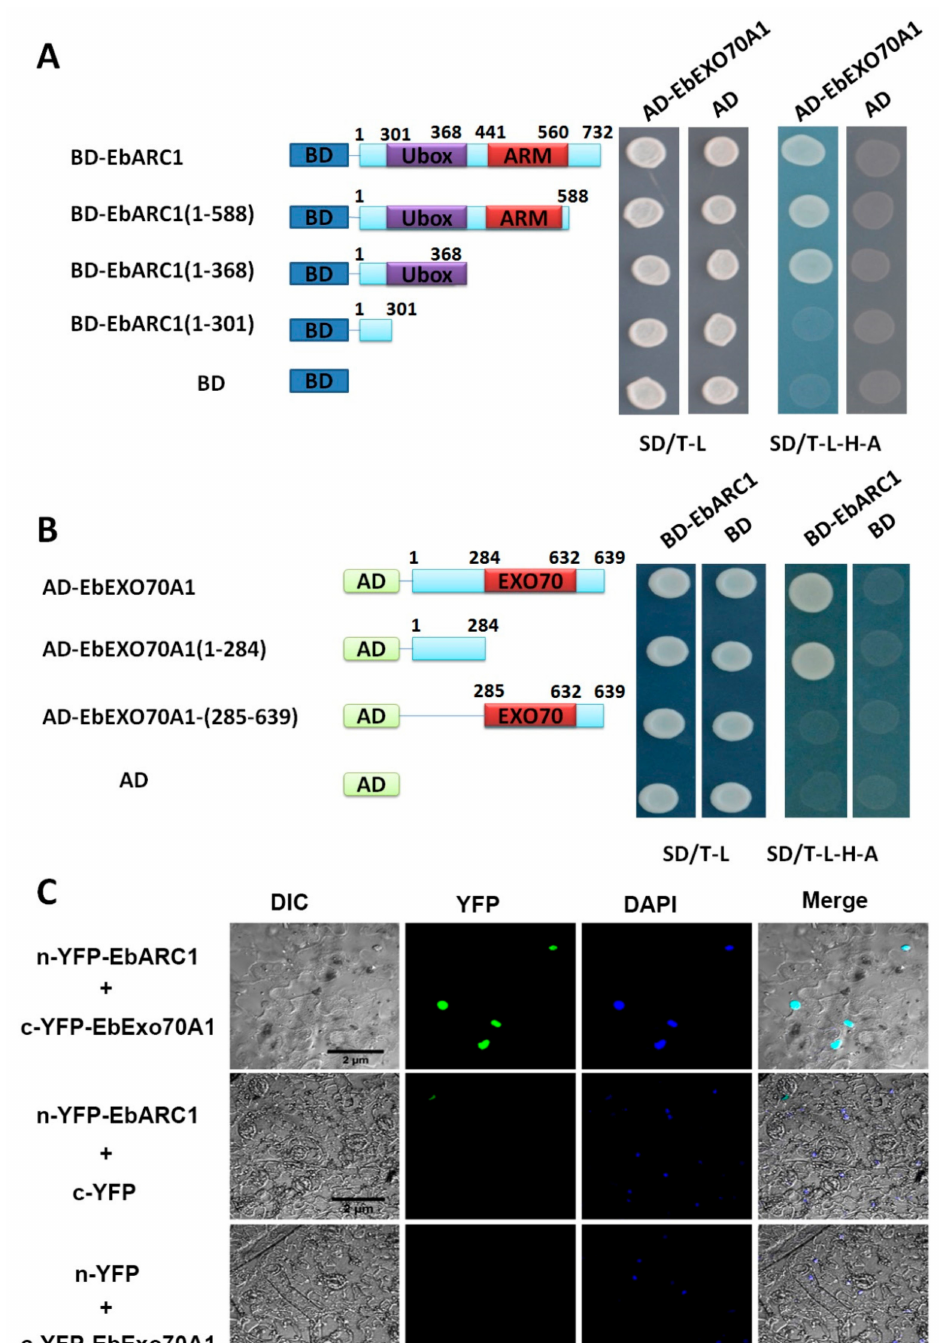
Figure 6. Protein interaction between EbARC1 and EbExo70A1. ( A ) Interaction between EbARC1 with EbExo70A1 was detected in the yeast two-hybrid (Y2H) system. pGBKT7 (BD) and pGADT7 (AD) were used as negative controls. The full-length EbARC1 and three truncated EbARC1 sequences were fused to the GAL4 DNA-binding domain (BD) in pGBKT7, while EbExo70A1 was inserted into the